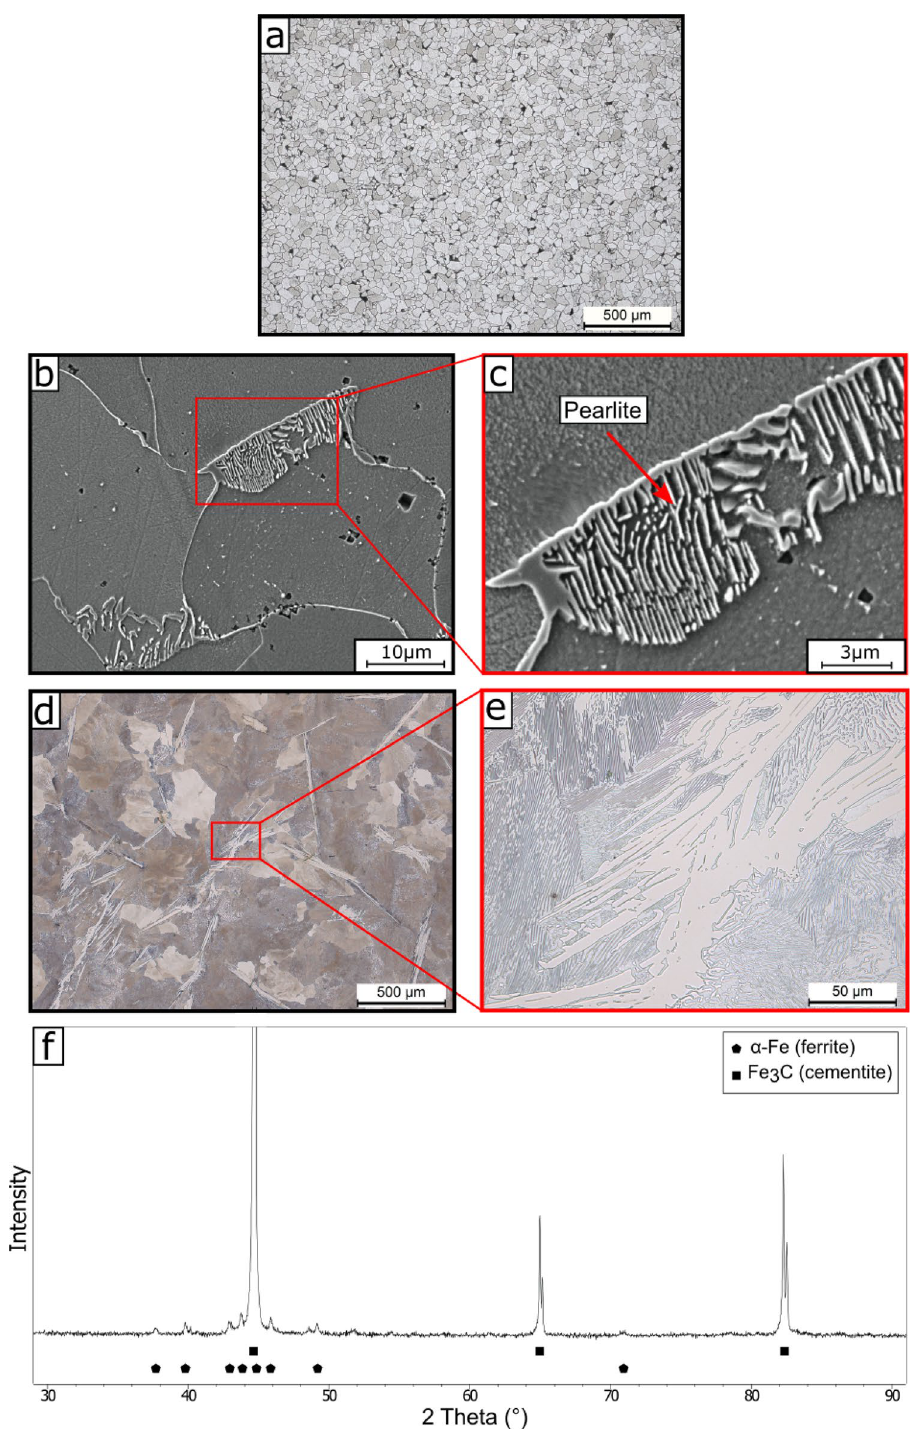
Fig. 3 Initial state of the collec- tor bar ( a – c ) and after service at CB.Top ( d , e ) with light microscopy ( a , d , e ) and SEM images for pearlite investiga- tion ( b , c ). A corresponding XRD pattern ( f ) of the collector bar in the middle position after service time with the reflections matched to the phase patterns of ferrite and